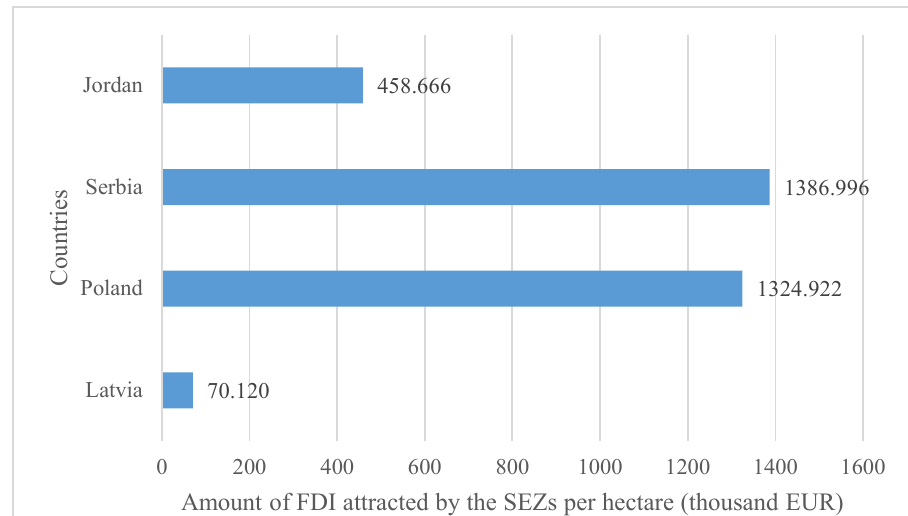
Fig. 4. FDI attracted by the SEZs per hectare, thousand EUR (Source: Relevant SEZ authorities,